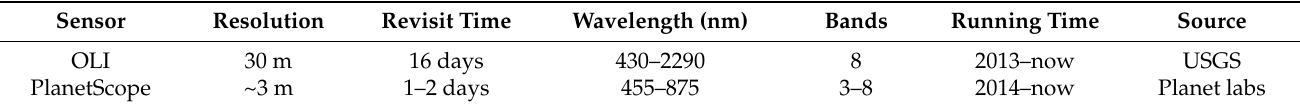
Table 1. Specifications of the satellite image used in this study.